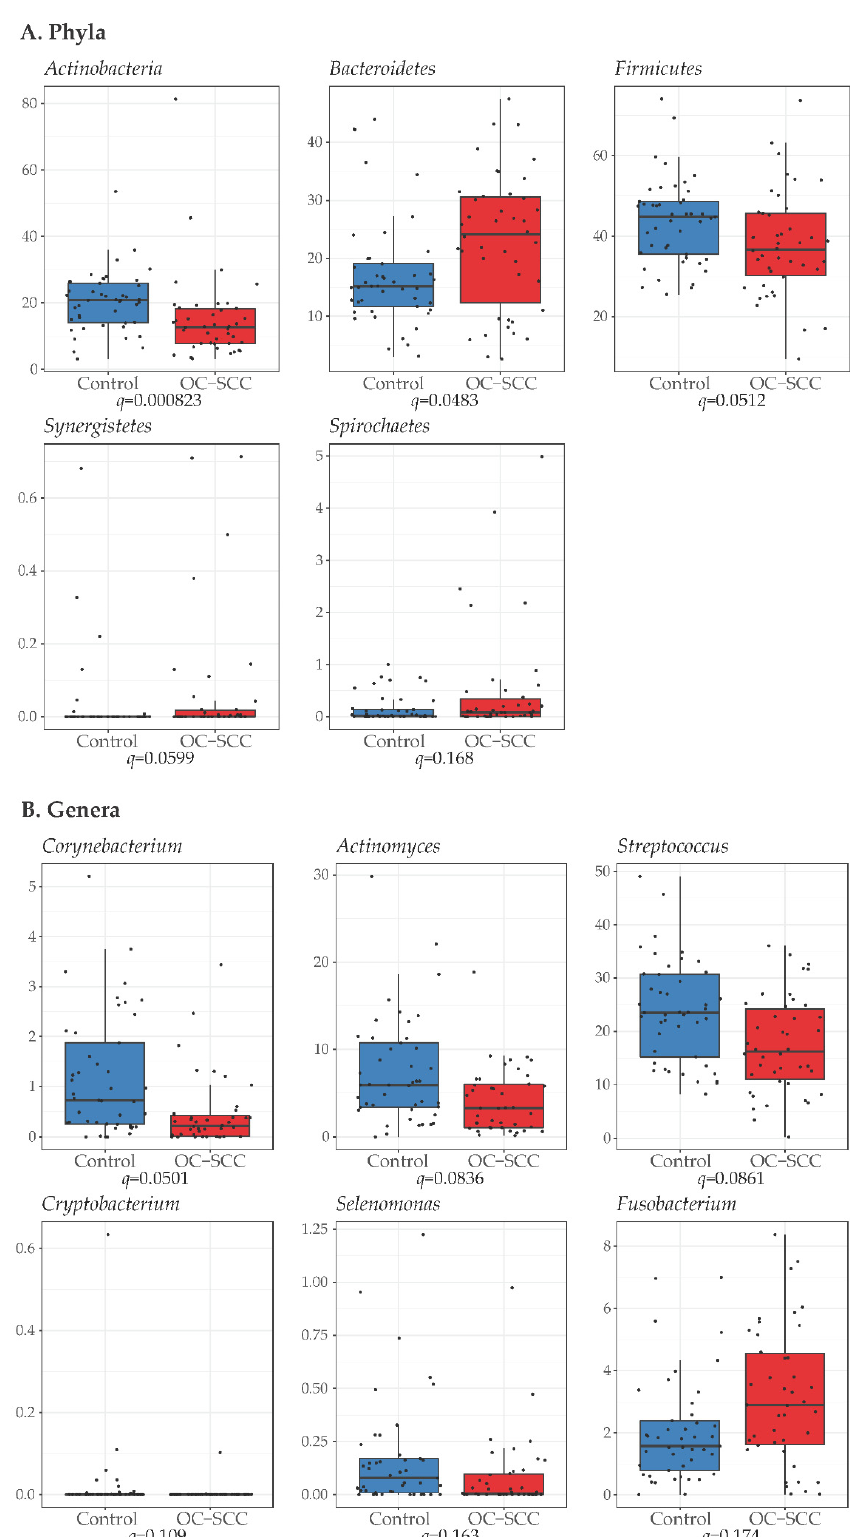
Figure 2. Differential bacterial phyla and genera between nonsmoking OC-SCC patients and non- OC-SCC control patients. The Y -axis shows relative abundance in percentage. The difference in the relative abundance of phyla ( A ) and genera ( B ) was evaluated by the Mann–Whitney test and a false discovery rate–adjusted p value ( q value) <0.20 was used as the threshold for significance.